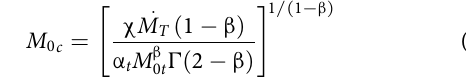
with β = 0.59 and m c = 9.02, as recommended by Rong et al. (2014) for the CSZ. According to the TGR distribution shown in Figure 2 , m (cid:21) 8.8 earthquakes are expected with a return period of 500 years ( λ m = 0.002), while m (cid:21) 9.0 earthquakes are expected with a return period of 1,000 years ( λ m = 0.001). Goldfinger et